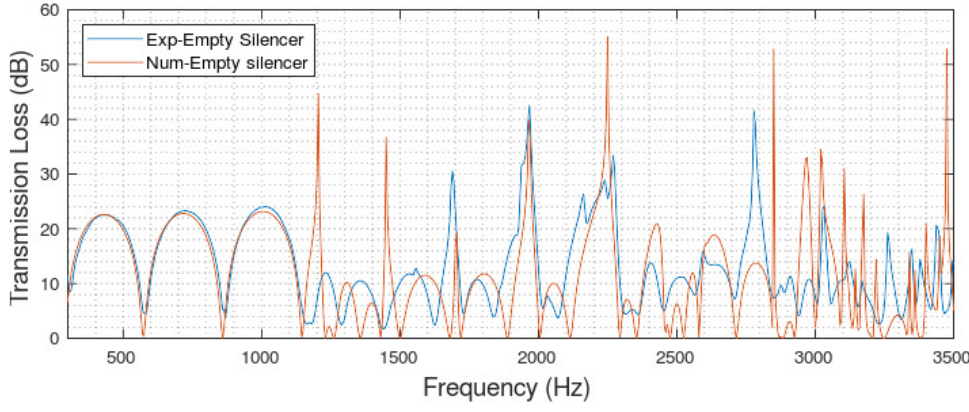
Figure 11. Experimental vs numerical model.